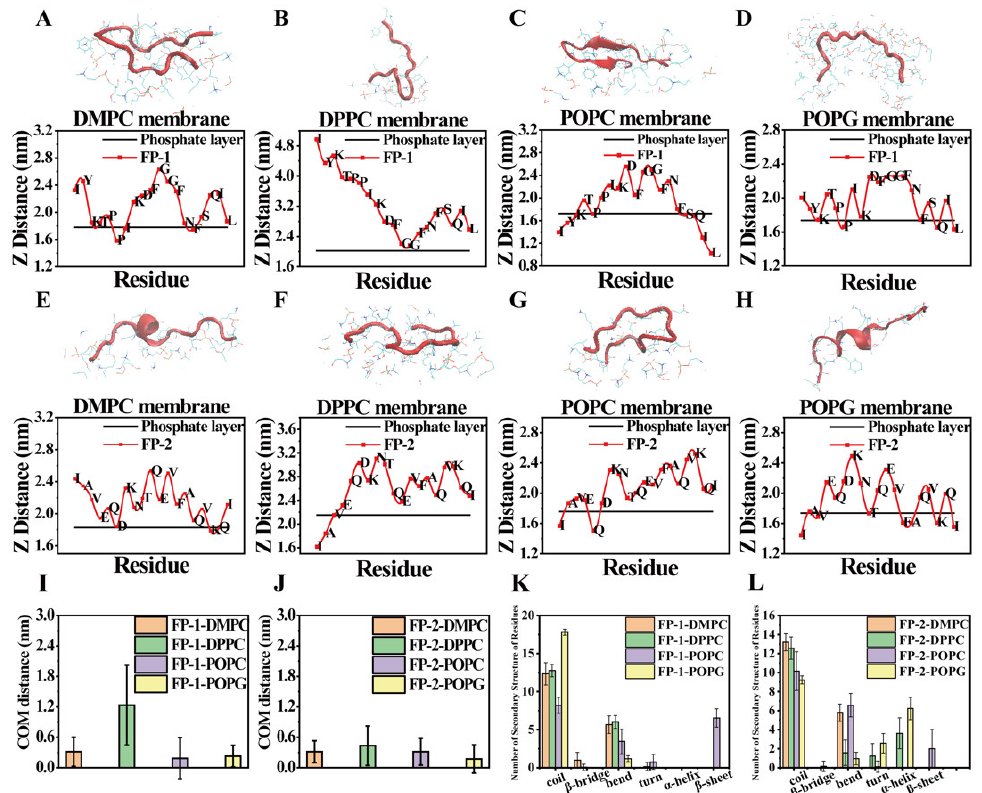
Figure 7. Adsorption of two functional-peptide residues to four lipid membranes. ( A – H ) The binding-configuration plots of the two functional peptides adsorbed onto the lipid bilayer (DMPC, DPPC, POPC, POPG). The two functional peptides are shown in red cartoon model; lipids are represented by blue lines. Plots showed the COM distance at Z direction of each amino acid with respect to the phosphate layer (black) of the bilayer (t = 500 ns). ( I , J ) The average COM distance between each amino-acid residue and the phosphate groups in every membrane system (t = 500 ns). Error bars denote standard deviation (s.d.). ( K , L ) The contents of secondary structures of the two functional peptides in four lipid membranes (t = 475–500 ns). Error bars denote standard deviation (s.d.).